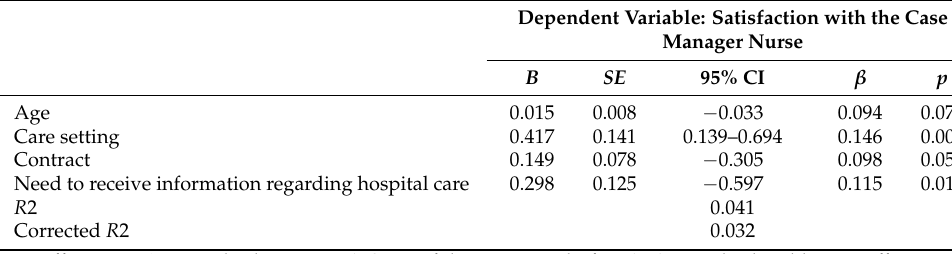
Table 5. Linear regression model to assess satisfaction with the case manager nurse (n = 437). Dependent Variable: Satisfaction with the